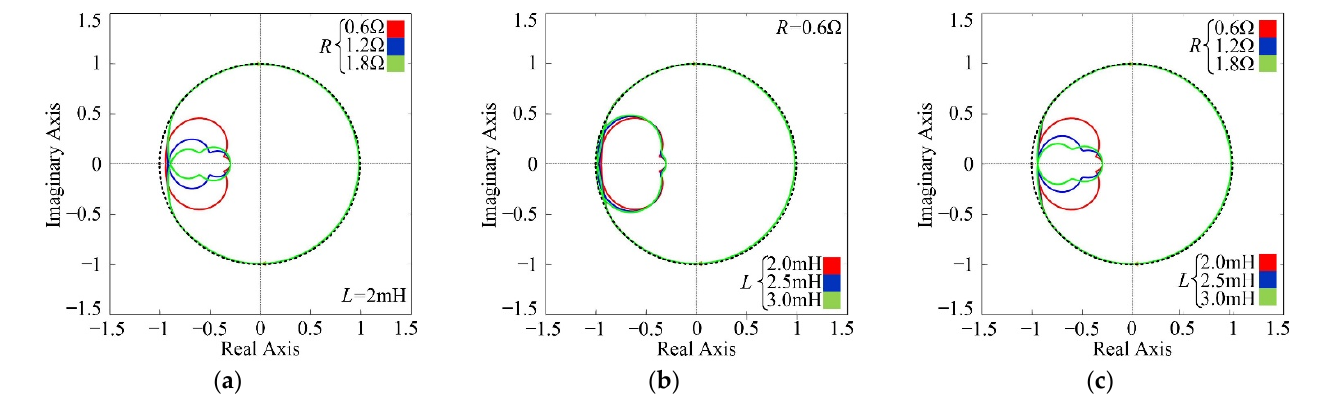
Figure 12. ( a ) Nyquist diagrams of H ( z ) with different R ; ( b ) Nyquist diagrams of H ( z ) with different L ; ( c ) Nyquist diagrams of H ( z ) with different R and L .